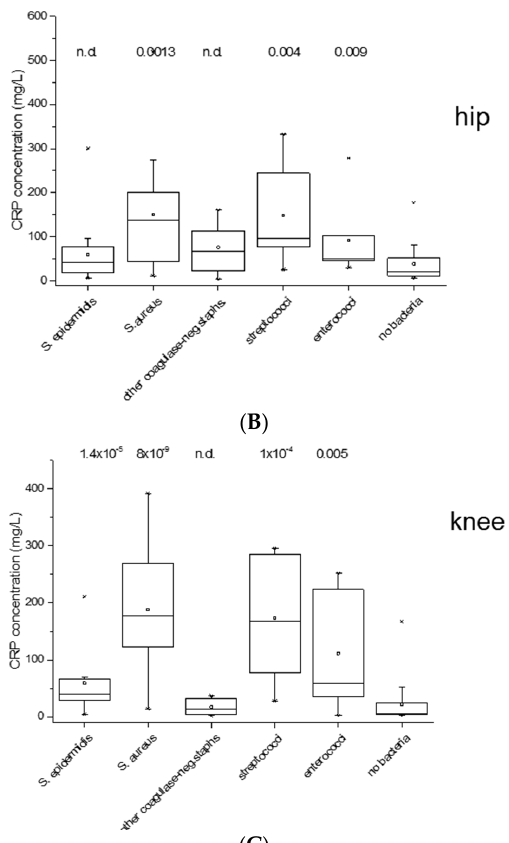
Figure 2. ( A – C ): CRP serum concentrations of all patients ( A ) included in the study, of patients with infected hip implants ( B ) and of patients with infected knee implants ( C ). Differences between culture-negative cases (no bacteria) and the five most frequent bacteria are calculated using the Mann-Whitney test. Significance level was determined as p < 0.05.